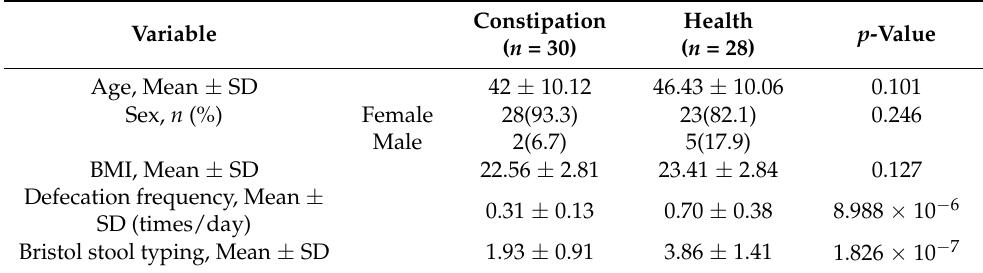
Table 1. Characteristics between patients of the FC group and the NC group. Variable